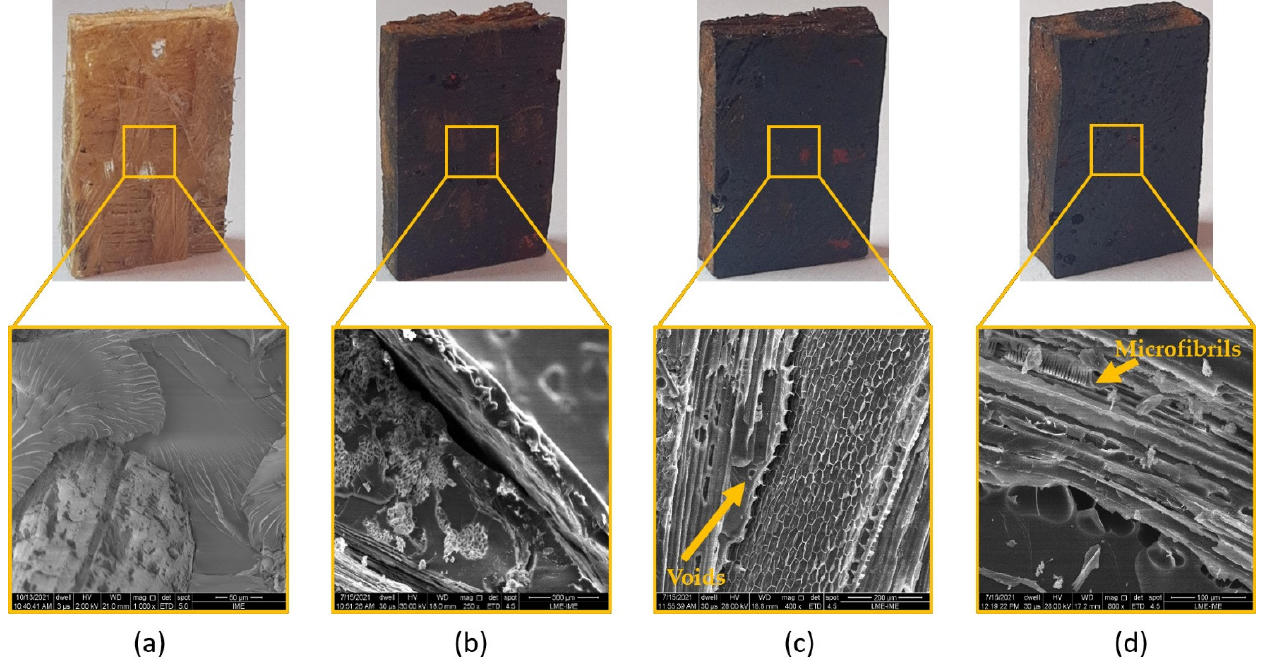
Figure 6. Visual changes and corresponding high magnification SEM micrographs of fique fabric-reinforced epoxy composites thermally aged in ( a ) 0 h; ( b ) 72 h; ( c ) 120 h; and ( d ) 240 h exposure time.